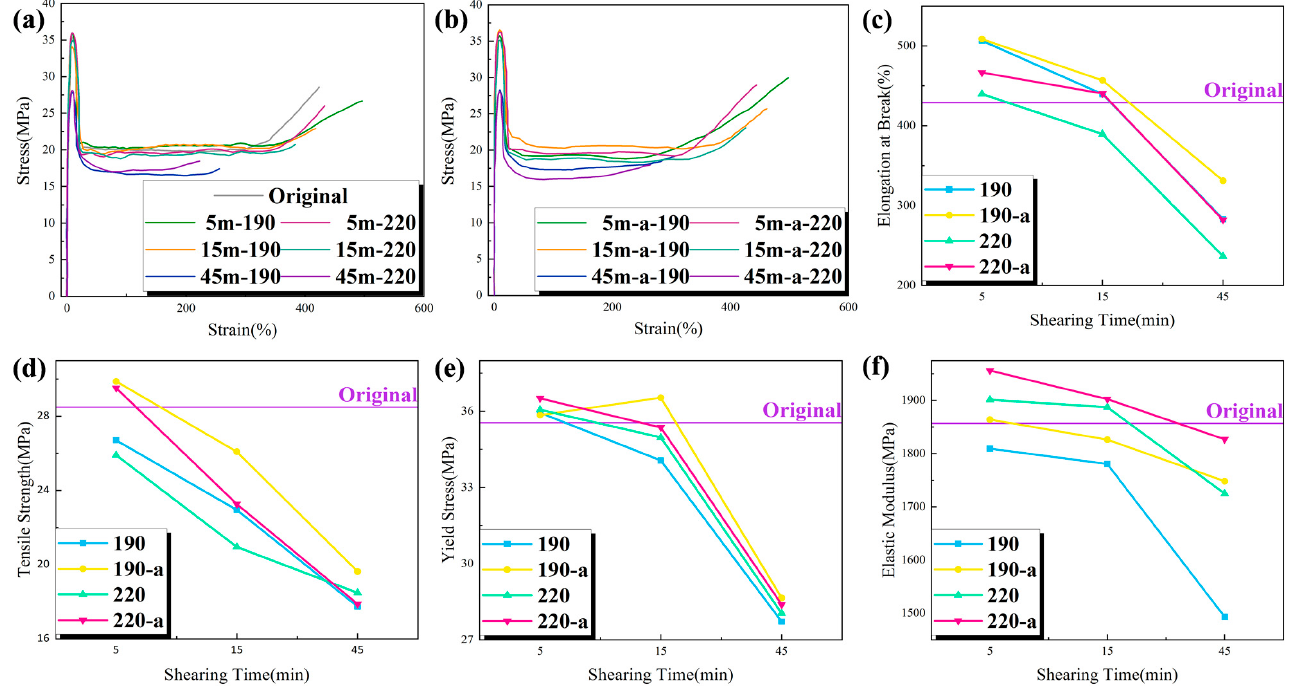
Figure 6. Stress–strain curves of each sample. ( a ): Stress–strain curves of samples without antioxidants; ( b ) Stress–strain curves of samples with antioxidants. ( c ), ( d ), ( e ) and ( f ) are elongation at break, tensile strength, yield stress, elastic modulus of each sample.